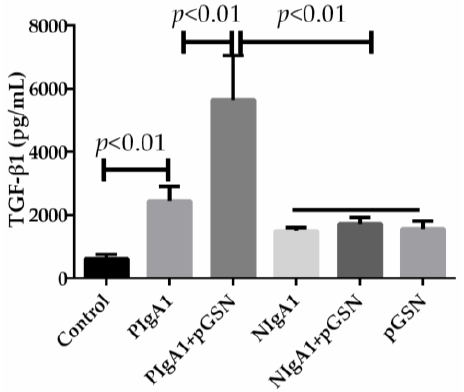
Figure 4. The comparison of TGF-β1 synthesis in six different HMCs treatment group. With the same content IgA1 (1.5 mg/mL), pGSN (10 µg/mL), and same time(48 h), TGF-β1 synthesis was up-